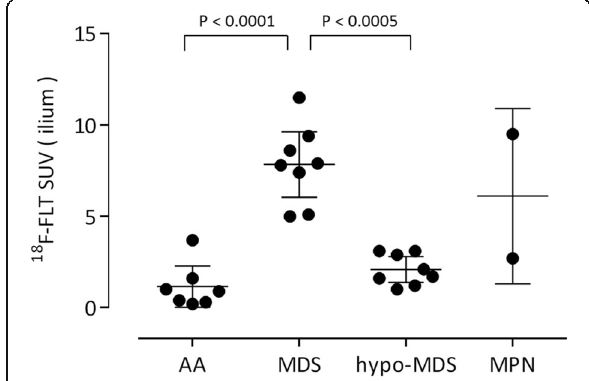
Fig. 6 18 F-FLT uptake in the ilium among AA, MDS, hypo-MDS, and MPN patients. Data are shown as the mean and 95% confidence interval for AA, MDS, and hypo-MDS patients, and as the mean and standard deviation for MPN patients. Significant differences in 18 F- FLT uptake were observed between MDS and AA ( P < 0.0001) or hypo-MDS patients ( P <